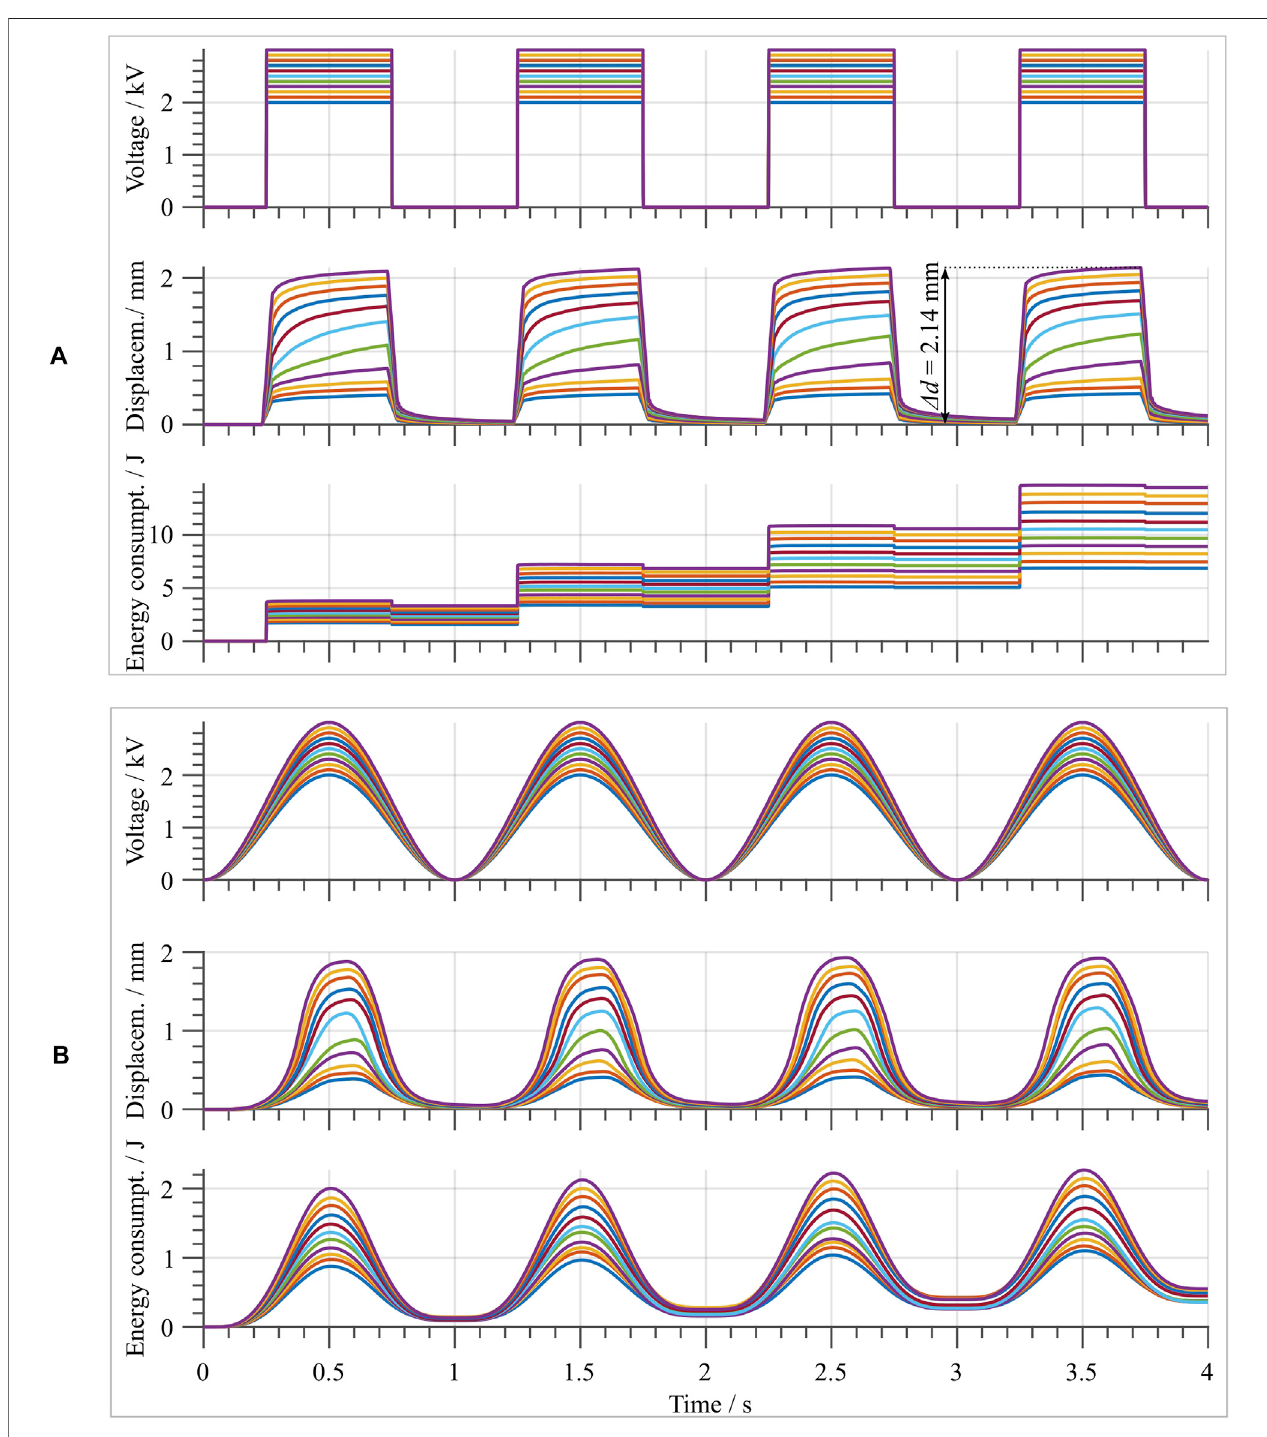
FIGURE11|(A) upperpart,showsthesquarewavevoltageinputsignalswithdifferentamplitudesrangingfrom2to3 kVinstepsof0 . 1kV.Centerandlowerparts show the laser-measured stroke of the fl at top, and the input energy supplied to the DEA for charging and discharging, respectively. (B) shows the same for sinusoidal voltage input signals with the same amplitudes as in (A) .